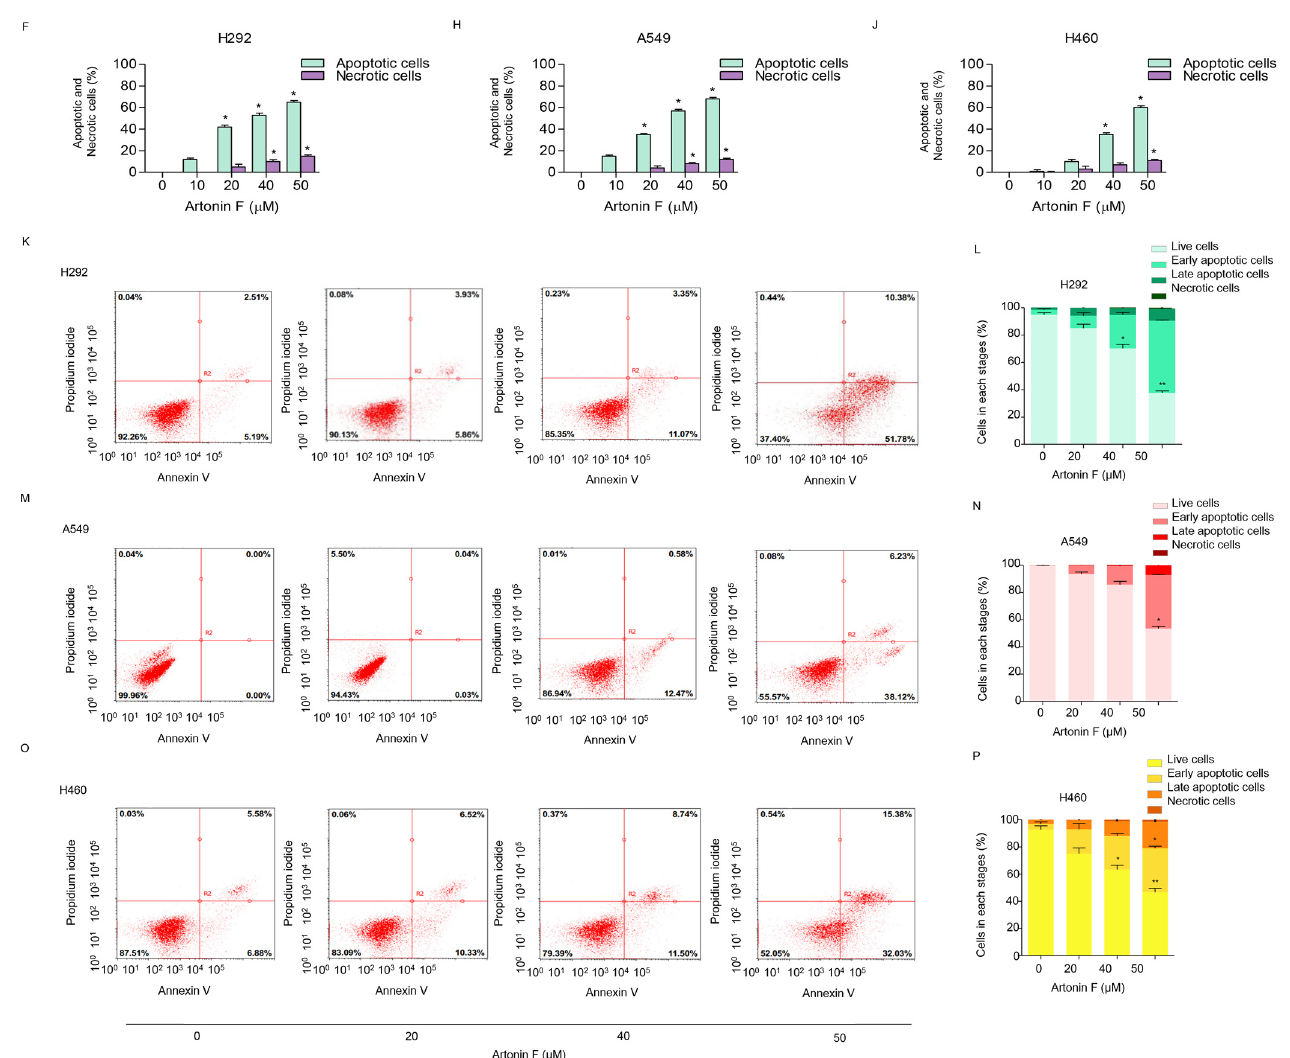
Figure 1. Cytotoxicity of artonin F on human lung cancer cells. ( A ) Chemical structure of artonin F. ( B – D ) Effect of artonin F on cell viability of lung cancer cells (H292, A549, and H460 cells) was assessed by the 3-[4,5-dimethylthiazol-2-yl]-2,5 diphenyl tetrazo-liumbromide (MTT) assay. ( E – J ) Morphology of apoptotic nuclei stained with Hoechst 33342 dye and propidium iodide in cells treated with artonin F, determined by visualized using fluorescence microscopy and percentages of nuclear fragmented and PI positive cells were calculated. ( K – P ) Apoptotic and necrotic cells were determined using Annexin V-FITC/PI staining with flow cytometry. Data are shown as the mean ± SEM ( n = 3). * p < 0.05, ** p < 0.01 versus the non-treated